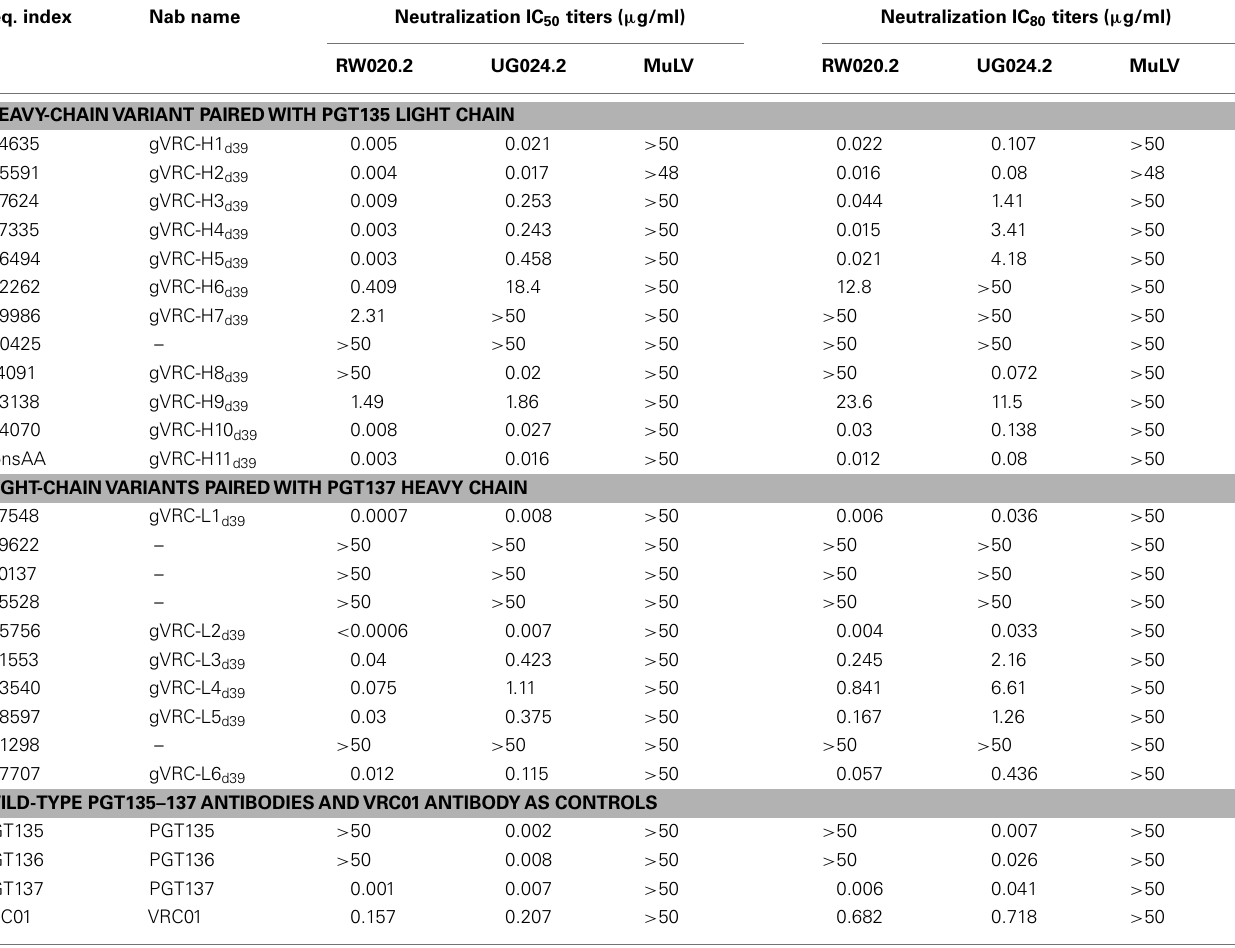
Table 4 | Neutralization titers of 21 chimeric antibodies derived from 454 pyrosequencing of donor 39 against HIV-1 pseudoviruses from cladeA and clade